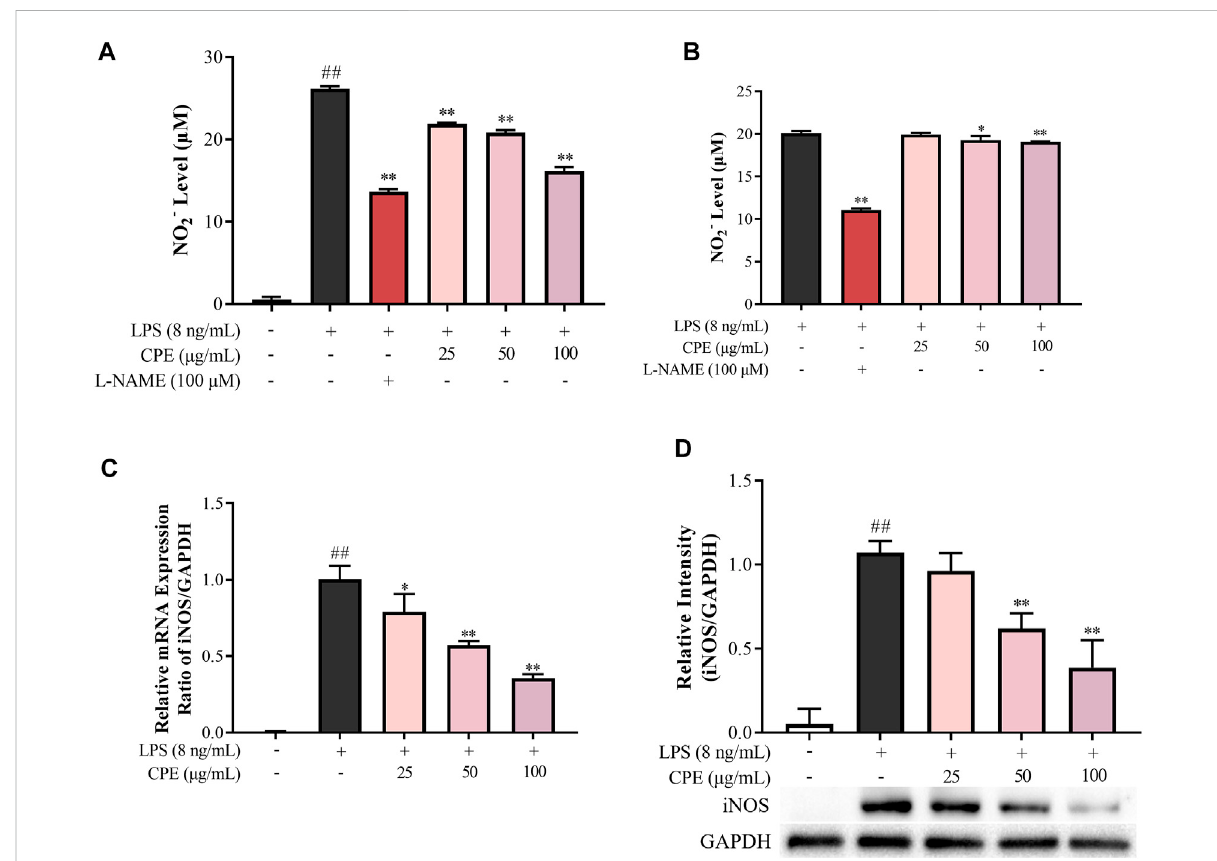
FIGURE 5 Effect of CPE on LPS-induced NO production in RAW264.7 macrophages ( n = 3). (A) Effect of CPE on supernatant NO in LPS-primed RAW264.7macrophages.CellsweretreatedwithLPS(8 ng/ml)withorwithoutCPEattheindicatedconcentrationsfor24 h.NOlevelinthemedium wasthendeterminedbyGriessreagent.L-NAMEat100 μ Mwasusedasapositivecontrol. (B) EffectofCPEoniNOSactivity.RAW264.7macrophages were treated with LPS (8 ng/ml) for 12 h to induce iNOS. LPS was then removed, and the cells were cultured with the CPE at different concentrationsfor afurther 12 h.Supernatant NO was measured by theGriess reagent to represent theiNOS activity.L-NAME(100 μ M) was usedas apositivecontrol. (C) EffectofCPEoniNOSmRNAexpression.RAW264.7macrophageswereculturedwithLPS(8 ng/ml)intheabsenceorpresence of CPE for 4 h. Total mRNA was then extracted. The mRNA level of iNOS was determined by RT-qPCR. (D) Effect of CPE on iNOS protein level. RAW264.7 macrophages were treated with LPS (8 ng/ml) with or without CPE for 24 h. Total intracellular protein was then extracted and the iNOS protein level was determined by Western blot. ## p < 0.01 vs. normal control group; * p < 0.05 and ** p < 0.01 vs. LPS alone